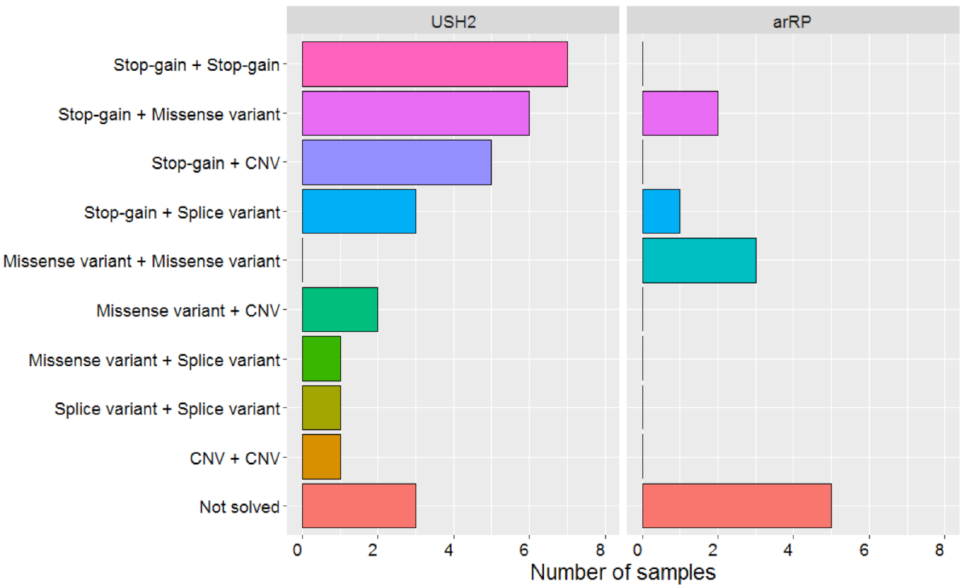
Figure 1. Overview of combinations of variant types identified in autosomal recessive retinitis pigmentosa (arRP) ( n = 11) and Usher syndrome type 2 (USH2) ( n = 29) cases. Splice variant: Canonical splice site variants and variants with any effect on splicing (both in frame and out-of- frame). CNV: Copy number